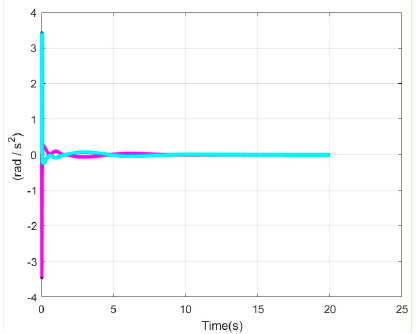
Figure 15. Angular accelerations of winches.